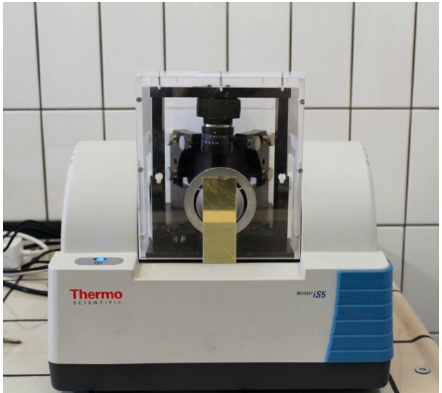
Figure 1. The FTIR instrument with custom-made external module used to analyze the samples.